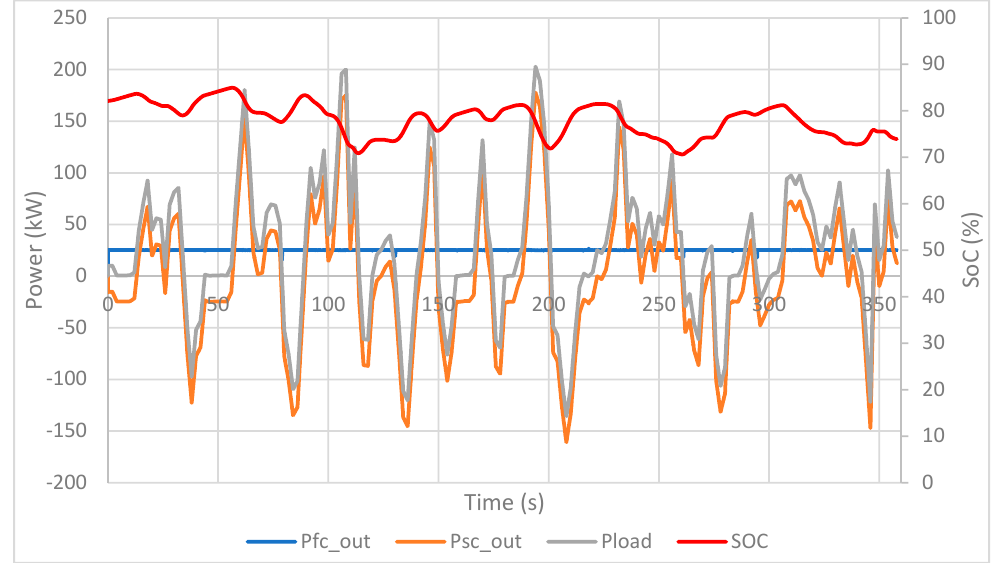
Figure 5. Power balancing and SoC change of the hybrid system for the peak power profile.